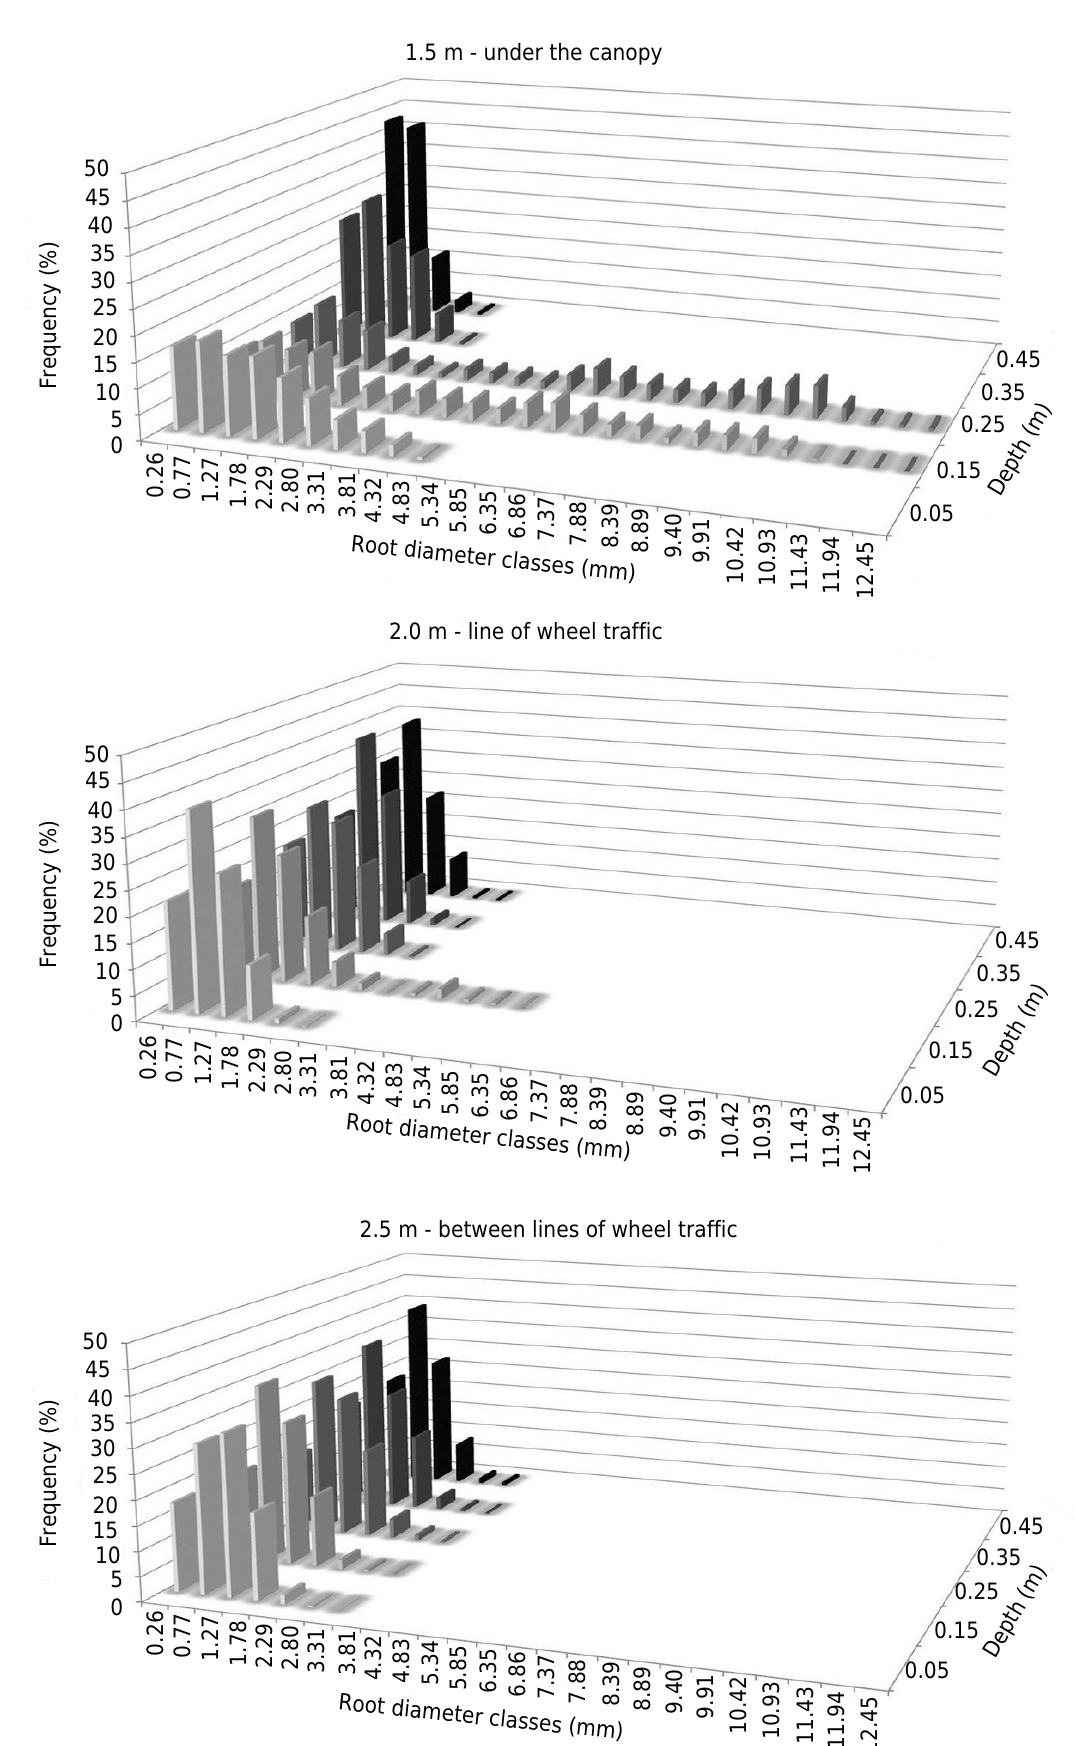
Figure 4. Frequency of root volumes for diameter classes and collection depths under the canopy, in the traffic line of the wheel sets, and in the portion between wheel sets of an orchard of ‘Maciel’ peach grafted onto